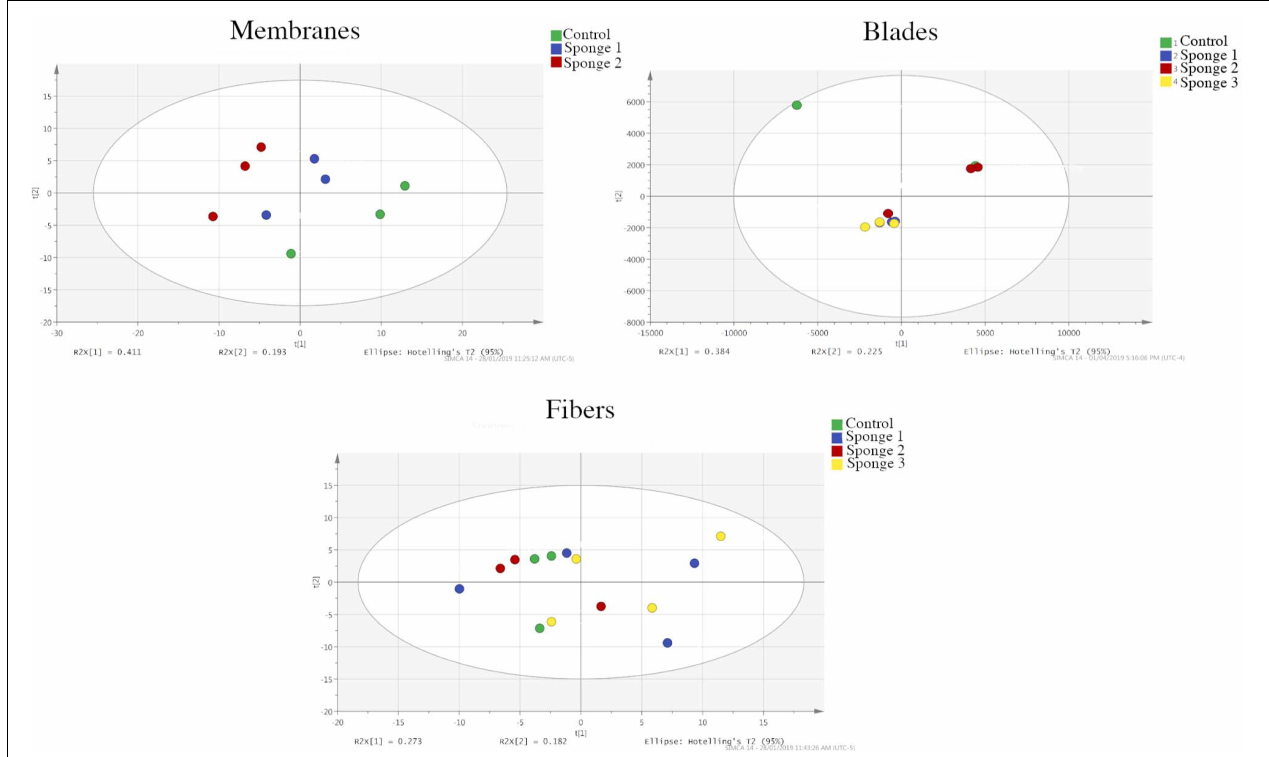
FIGURE 4 | Principal component analysis plots showing the separation of the features of the analytes extracted via membranes, blades, and fibers in both the experimental and control groups. Membrane devices show clear separation, while the fiber-based devices show poor